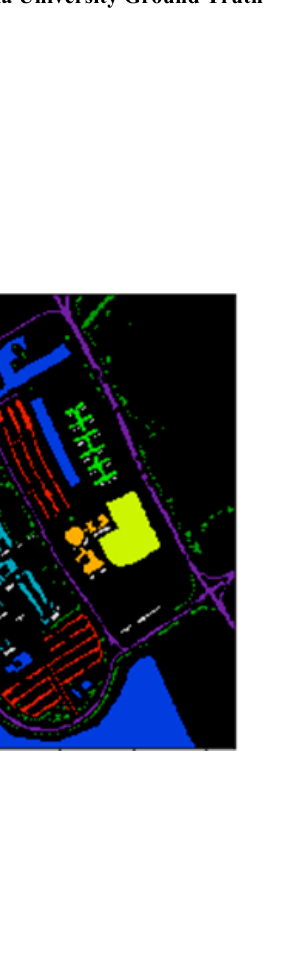
Figure 5: Pavia University Dataset: Classification maps for indicative CNN-based